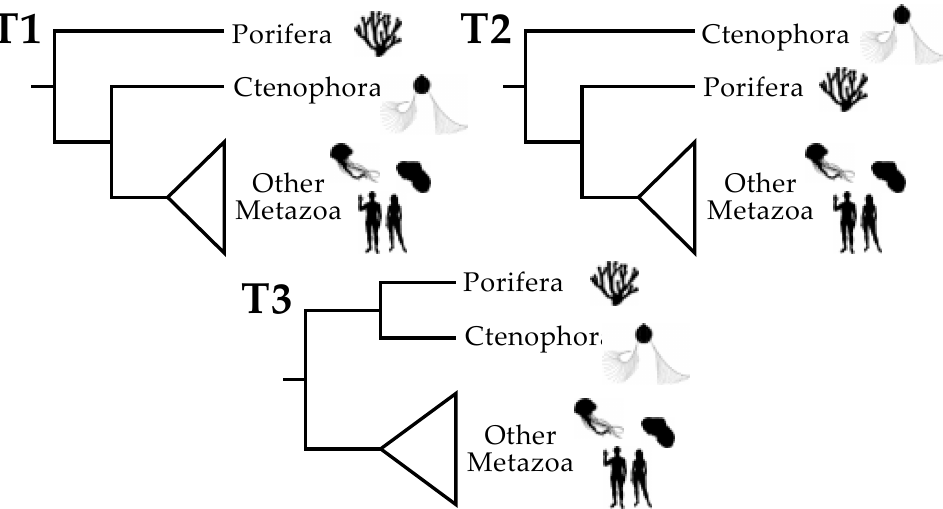
Figure 1. The three plausible topologies for basal Metazoa. The focal taxa are Porifera (sponges), Ctenophora (ctenophores or “comb jellies”), and all other Metazoa. “Other Metazoa” is a clade called Parahoxozoa [32] that comprises Cnidaria (jellyfish, corals, and sea anemones), Placozoa (a phylum of “flat animals” that comprises at least three genera [33]), and Bilateria (all other animal phyla). There are three plausible positions for the metazoan root. T1 places the root between the sponges and all other extant animals: this is the “traditional” position of the root based on morphology [34] and it has appeared in some phylogenomic studies. T2, which places the metazoan root between ctenophores and other animals, has been found in many other phylogenomic studies. T3 places the root between a Porifera + Ctenophora clade and the other metazoans. T3 is arguably the least plausible topology, although it has also been recovered in some phylogenetic analyses [20,22,29] (although recovery of T3 is limited to a subset of analyses in those studies). Animal silhouettes are from http://phylopic.org (accessed on 17 January 2019).